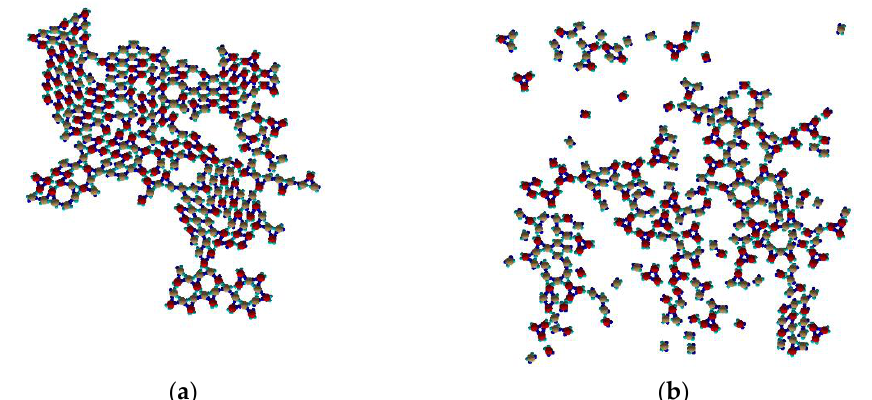
Figure 9. Growth structure from concentration of monomers type I:type II = 1:2, after 5.9E7 MC steps: ( a ) T* = 0.08; ( b ) T* =